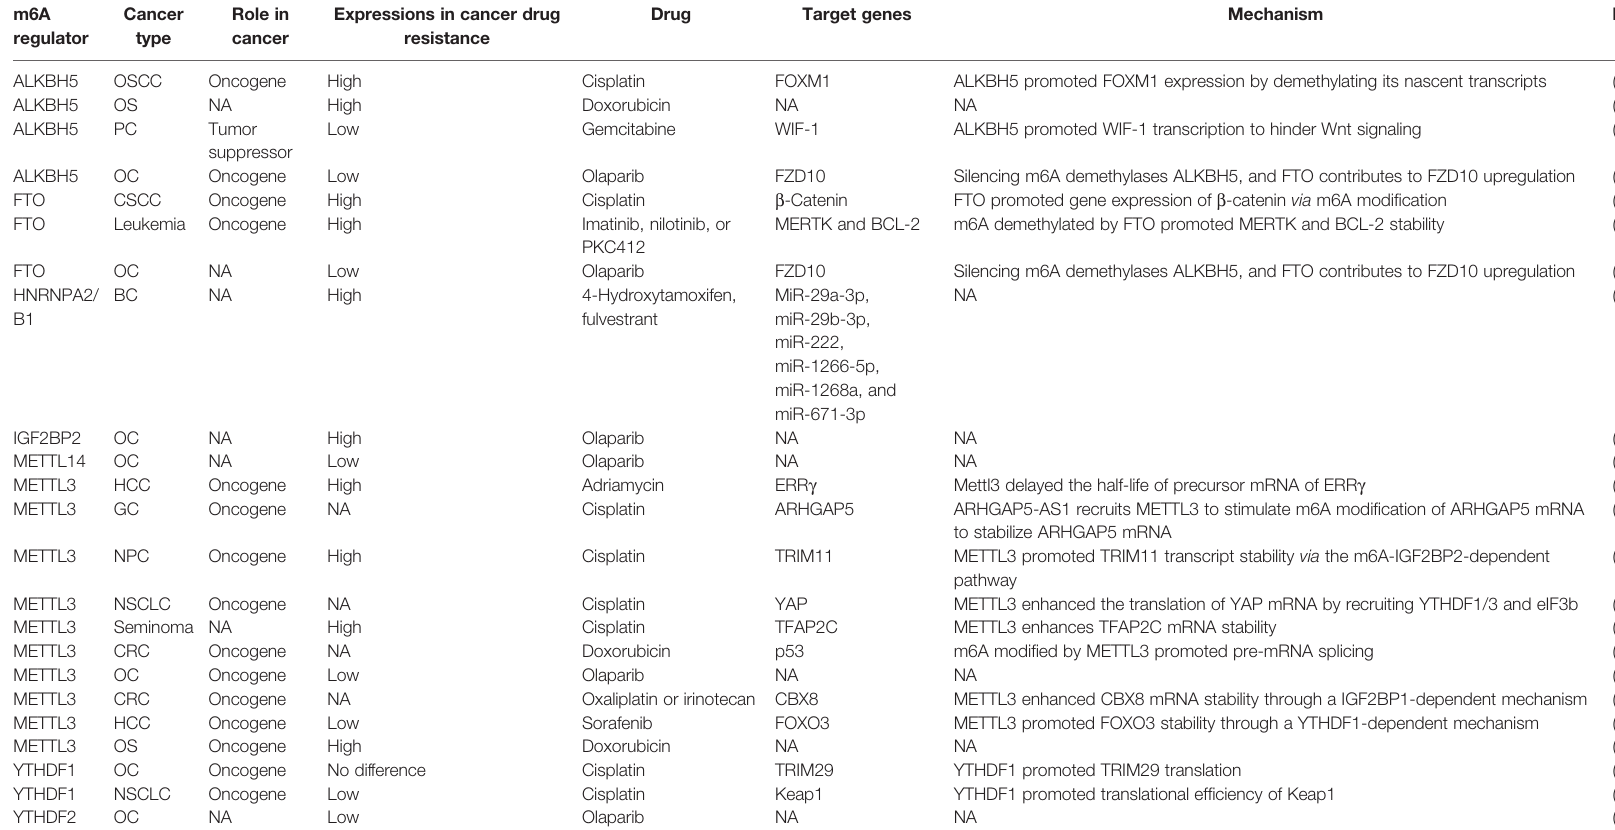
TABLE 1 | The role and regulatory mechanism of m6A regulator in cancer drug